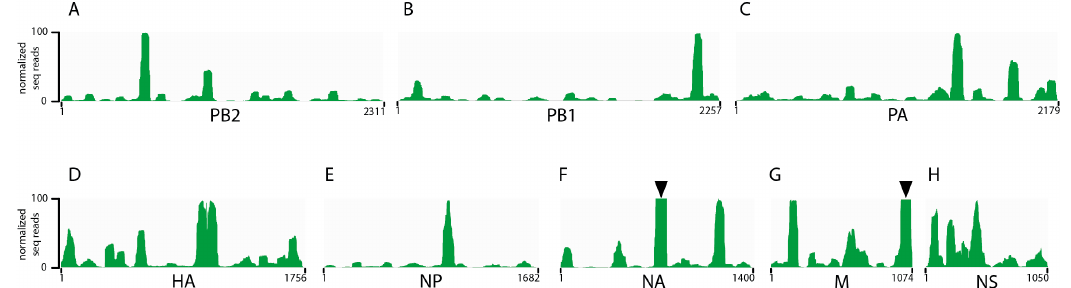
Figure 2. The NP binding profile for the IBV B/Texas/02/2013 strain ( A – H ). The abundance of NP on each vRNA segment was examined using HITS-CLIP analysis on purified virions with an anti-IBV NP specific antibody. A representative profile for each segment is presented as an IGV track. The nucleotide lengths and segment names are shown on the x-axis. Normalized reads based on the highest peak excluding “super peaks” (black arrowheads) are displayed on the y-axis.